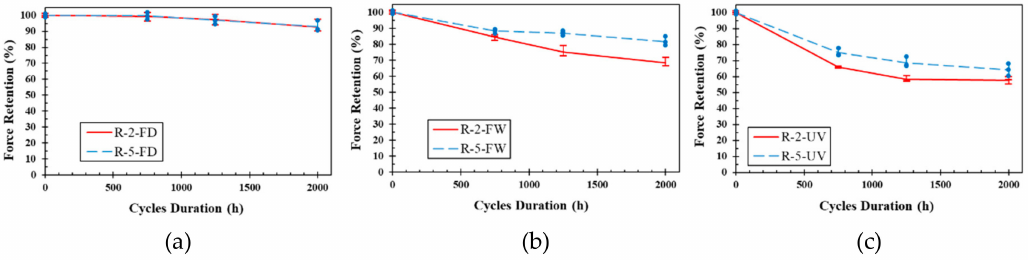
Figure 13. Retention ultimate tensile strength vs. exposure period of RL: ( a ) Dry freeze / thaw cycles, ( b ) wet freeze / thaw cycles and ( c ) UV and water vapor condensation cycles.